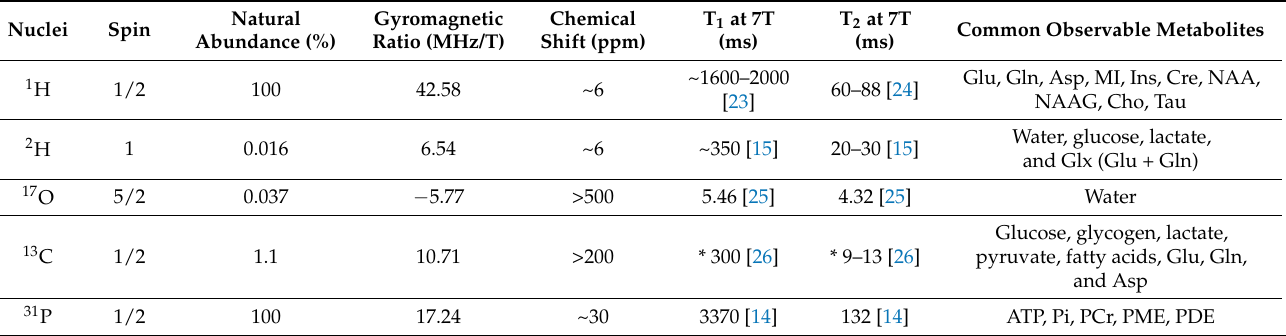
Table 1. MR characteristics of X-nuclei. Relaxation times of water in the human brain are presented for the nuclei 1 H, 2 H, and 17 O. For 13 C, relaxation times are denoted for liver glycogen from rat at 8.4T *. 31 P- relaxation times are represented for PCr resonance in the human brain. An approximate chemical shift is represented for in vivo spectral range for each